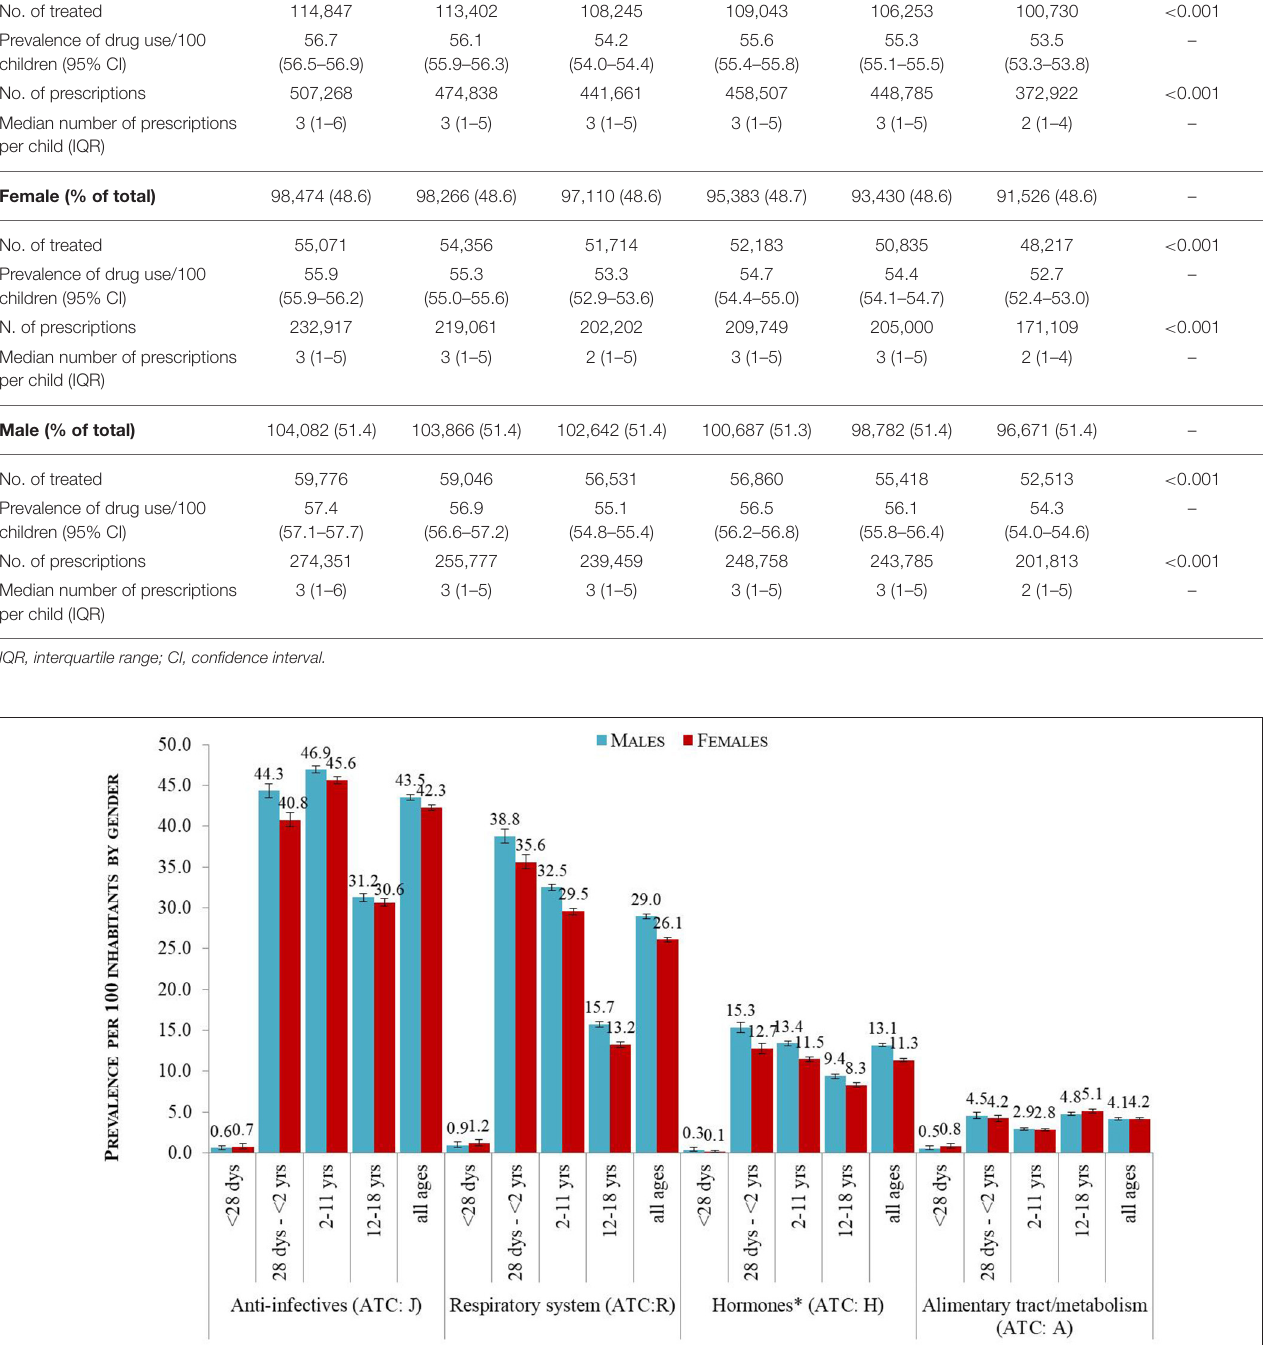
Frontiers in Pharmacology | www.frontiersin.org